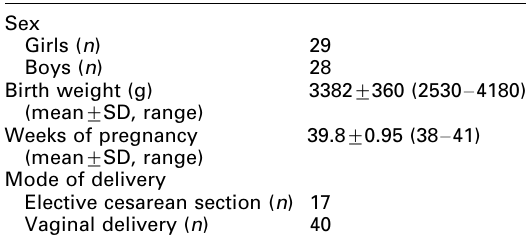
Table 1. Clinical characteristics of